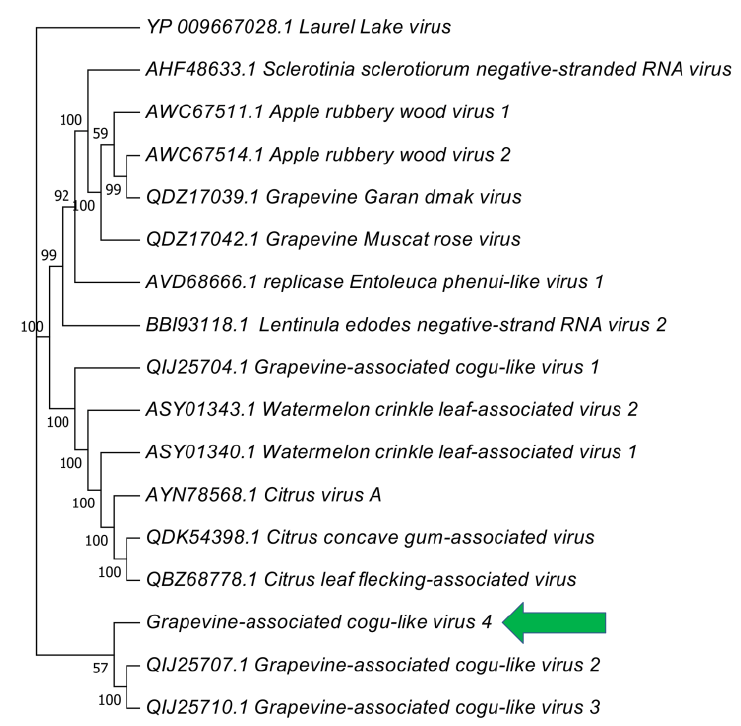
Figure 2. Phylogenetic analysis of a selected number of Coguvirus-like RNA-dependent RNA polymerases (RdRP). The newly identified virus is highlighted by the green arrow. Phylogeny was constructed by maximum likelihood algorithm and 1000 bootstrap replicates.